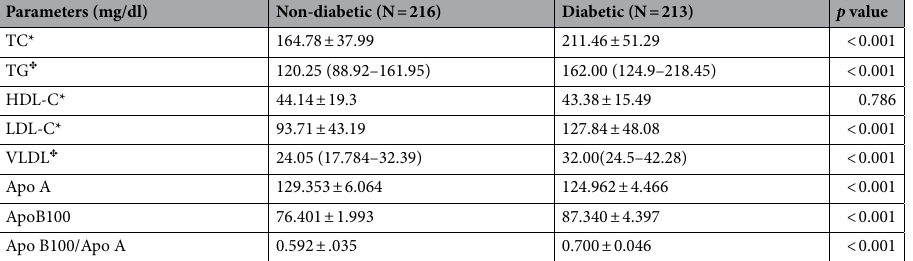
To quantify the relationship between an exposure and a disease, association was measured as odds ratio. Logistic regression, univariate, bivariate and multivariate analysis were performed to identify whether there is any associations between the SNP’s , triglycer- ides, insulin and risk of T2DM. A total of six predictive models for genotype (CG + GG) were studied to assess the association of genotype with T2DM. Three univariate model: Genotype (CG + GG) (model 1), TG (model 2), Insulin (model 3); two bivariate model: genotype and TG (model 4), genotype and insulin (model 5) and one multivariate model including genotype, TG and insulin (model 6) (Fig. 1).